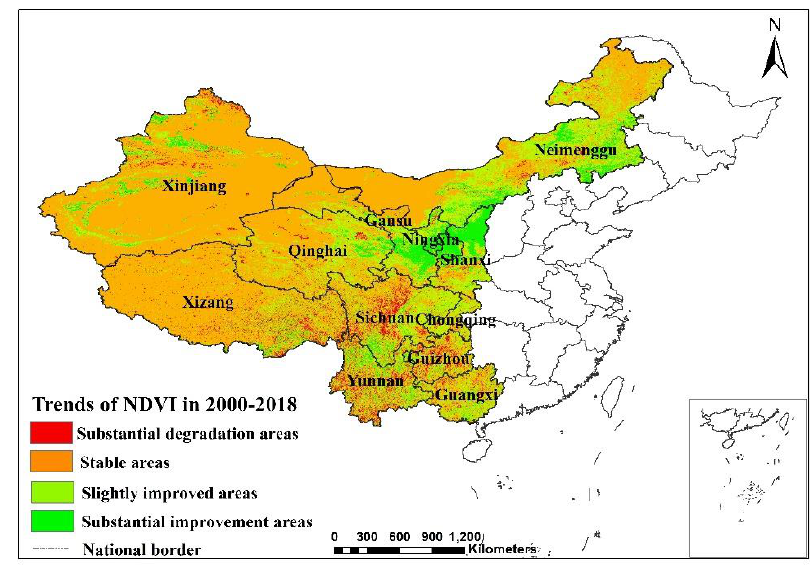
Figure 4. Annual NDVI change trend of vegetation in the growing season of west China from 2000 to 2018.